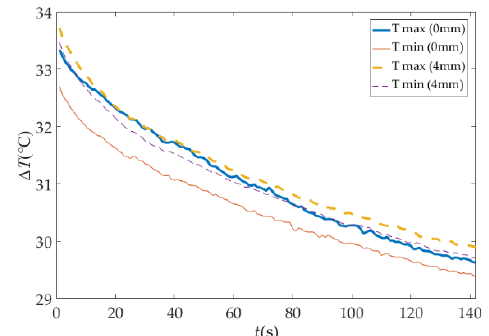
Figure 17. The maximum and minimum temperature of the 0 mm and 4 mm depth damaged.